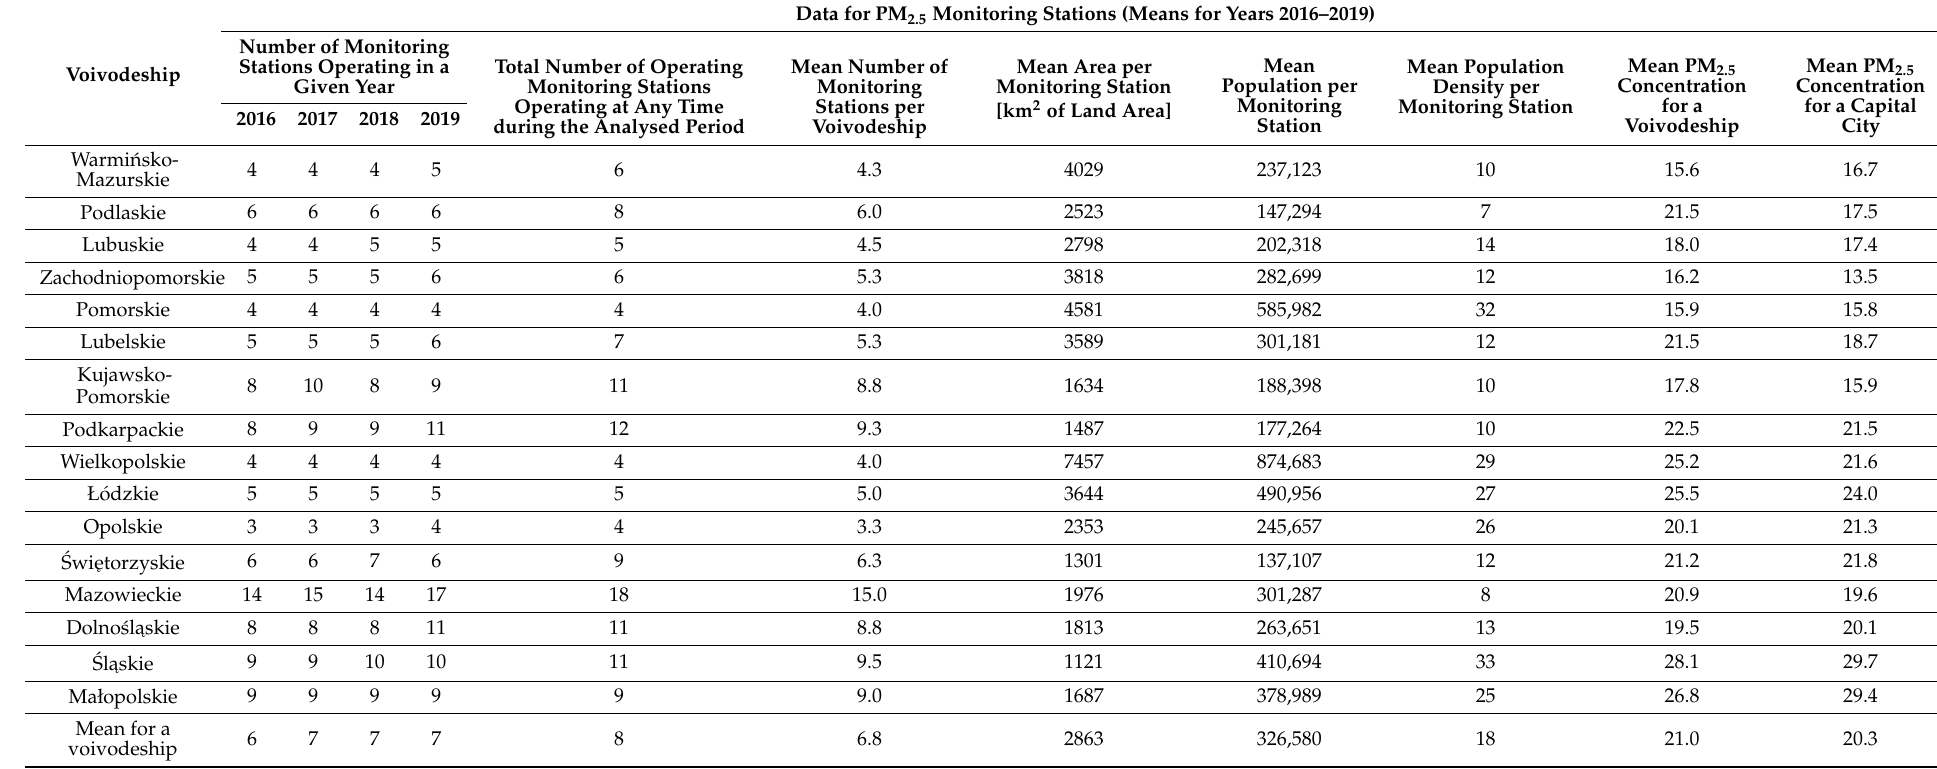
Table 3. General characteristics of PM 2.5 monitoring stations operating between years 2016–2019 in